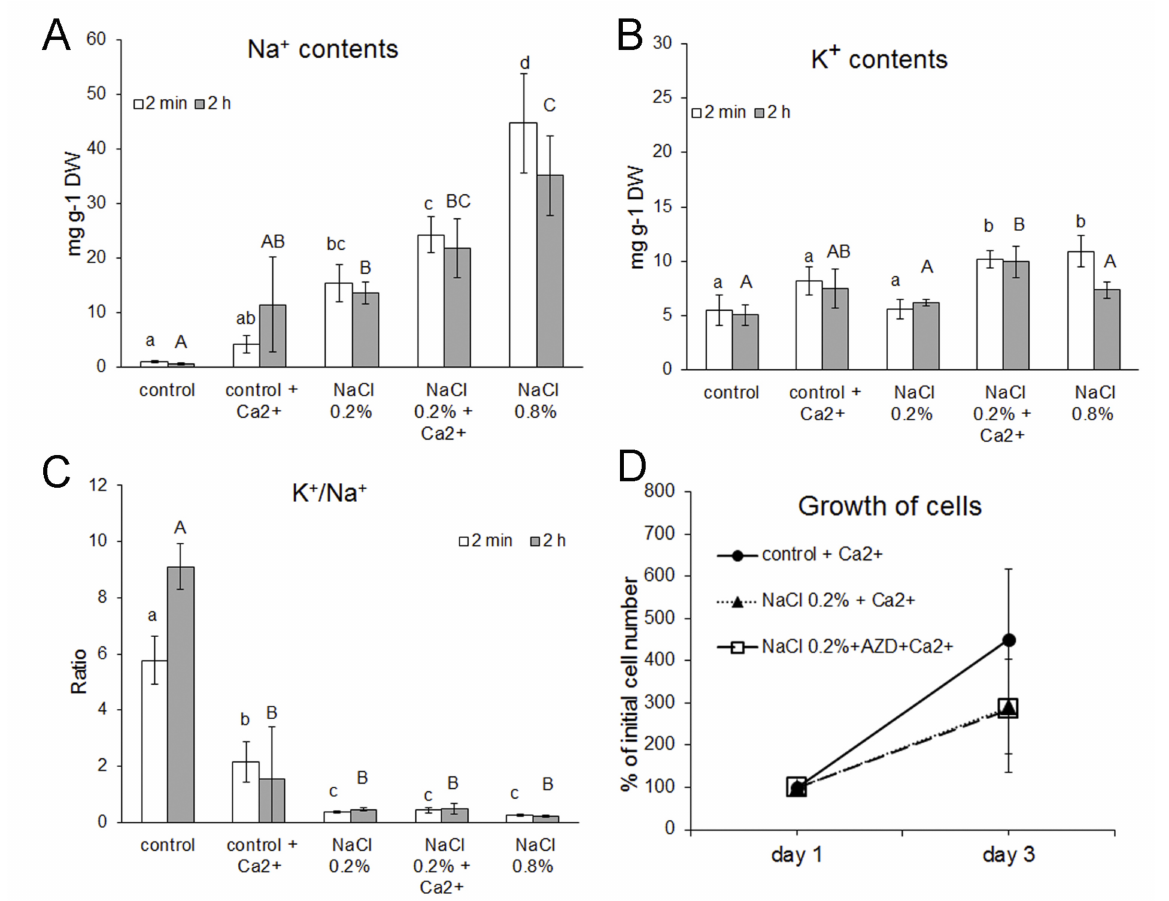
Figure 2. Levels of Na + ( A ) and K + ( B ) and K + /Na + mass ratios ( C ) in Haematococcus lacustris cells after transfer to NaCl-containing medium. Mean values ± SD are shown. ( D ) Growth of H. lacustris in OHM containing 1 mM Ca 2+ after transfer of the cells to fresh medium (control) or fresh medium containing 0.2% NaCl with or without addition of 0.2 µ M AZD8055 (AZD). Data (mean values ± SD) from one experiment run in triplicates are shown; the cell density at day one was set to 100% for all cultures. Different letters indicate significant differences between variants at the level of p < 0.05 or lower according to one-way ANOVA and post hoc Tukey test; lowercase and uppercase letters are for measurements taken 2 min and 2 h after transfer,